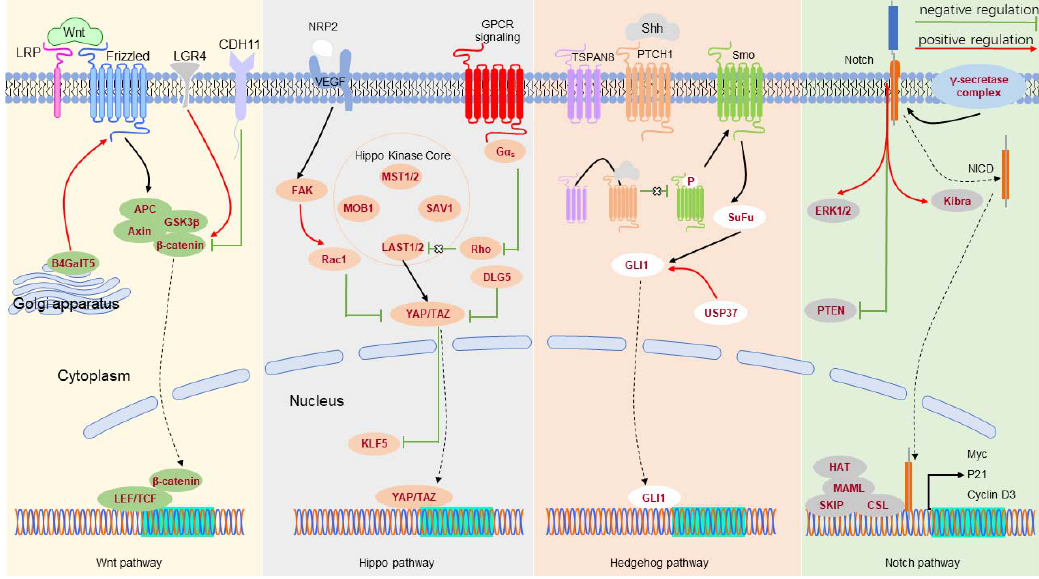
Figure 1. Critical signal transduction pathway networks associated with BCSCs.